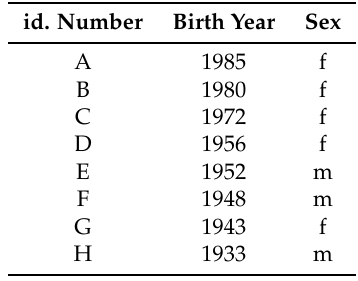
Table 1. List of